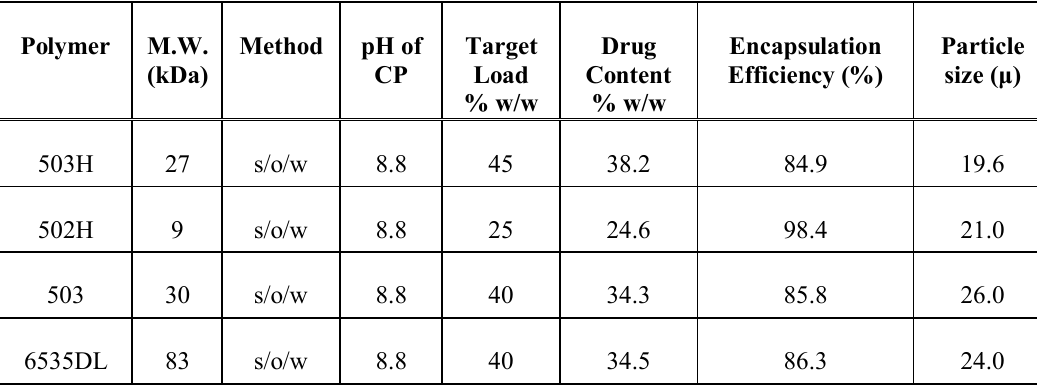
Table 1 - Preparation parameters and particle size of Sertraline HCl